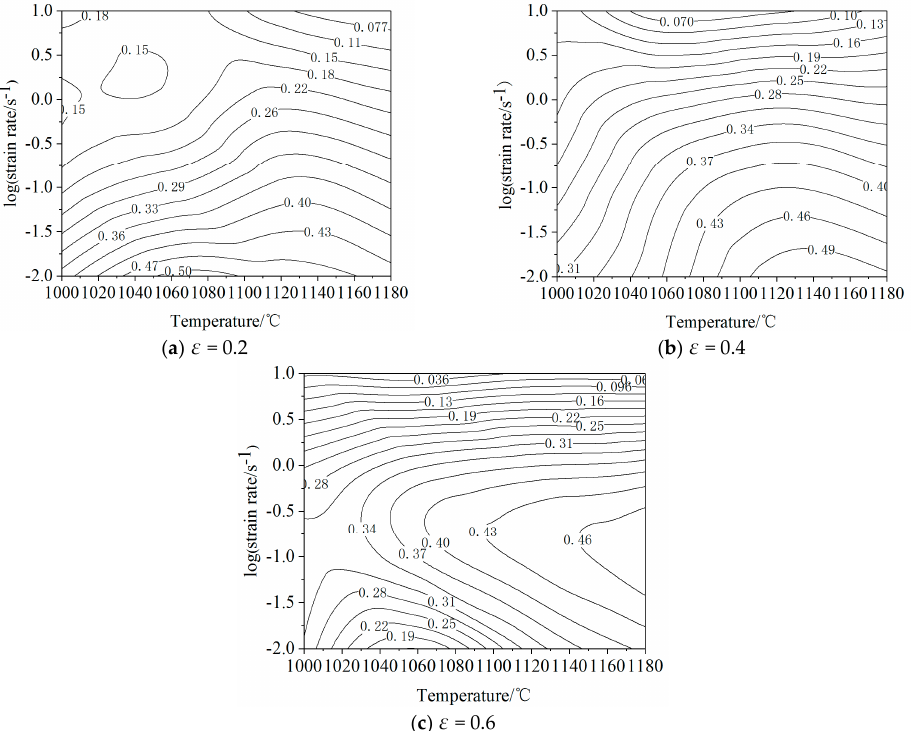
Figure 8. Energy dissipation map of 21-4N heat-resistant steel with strain of ( a ) 0.2; ( b ) 0.4; ( c ) 0.6. Materials 2018 , 11 , x FOR PEER REVIEW